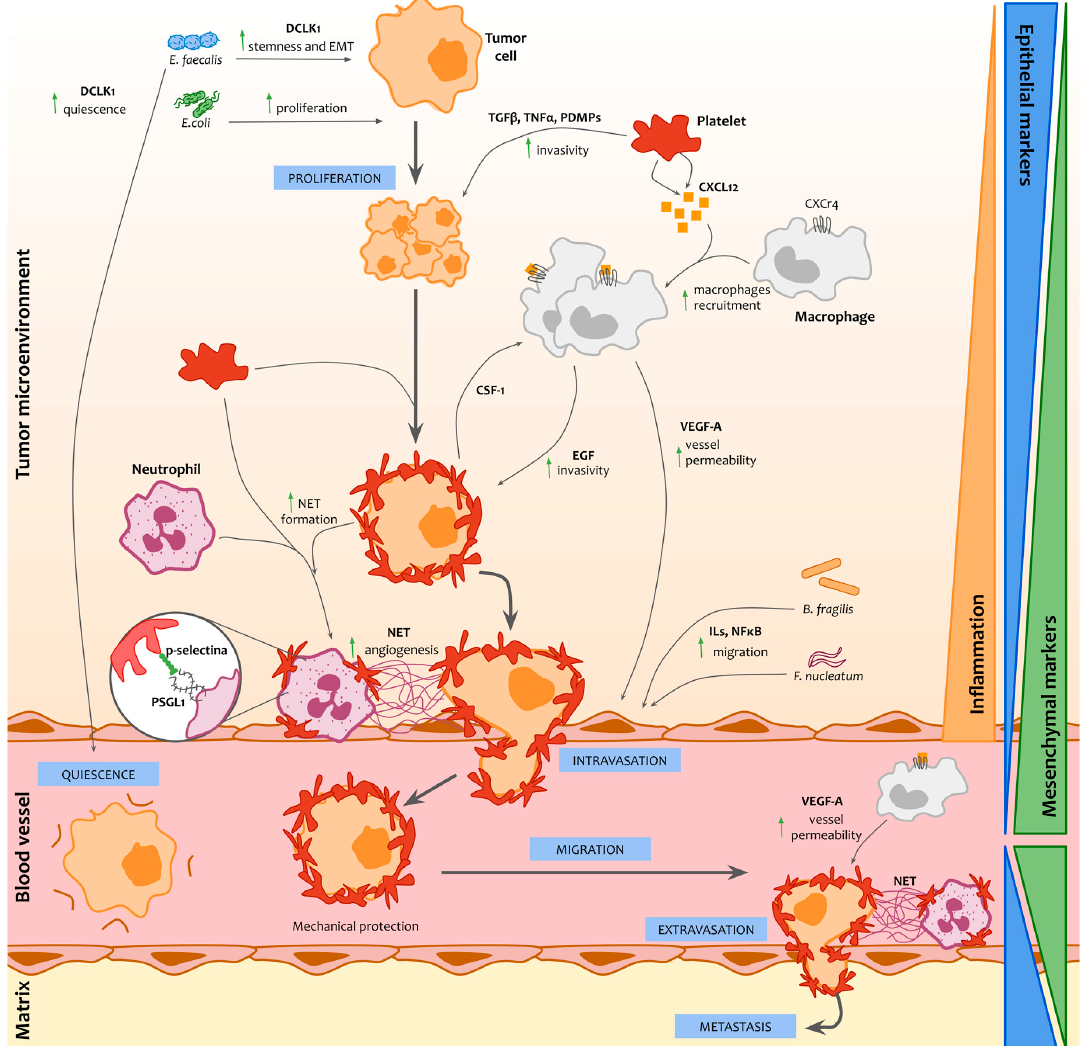
Figure 1. Interactions between circulating tumor cells (CTCs), immune system cells, and microbiome. Metabolites and cytokines produced by bacteria such as Bacterioides fragilis , Enterococcus faecium , Escherichia coli , and Fusobacterium nucleatum facilitate proliferation and migration of circulating tumor cells (CTCs), promote stemness and epithelial to mesenchymal transition (EMT), and help CTCs to enter quiescence. Furthermore, platelets interact with proliferating tumor cells directly, by formation of CTCs-platelet complexes allowing CTCs to escape the immune system but also indirectly, through three different ways: secretion of growth factors such as TFG β , TNF α either alone or enclosed in platelets-derived microparticles (PDMPs) that increase invasivity of CTCs; secretion of chemokines such as CXCL12, increasing macrophages recruitment, what ultimately impact on invasivity and vessel permeability through epidermal growth factor (EGF) and VEFG-A, respectively; and formation of